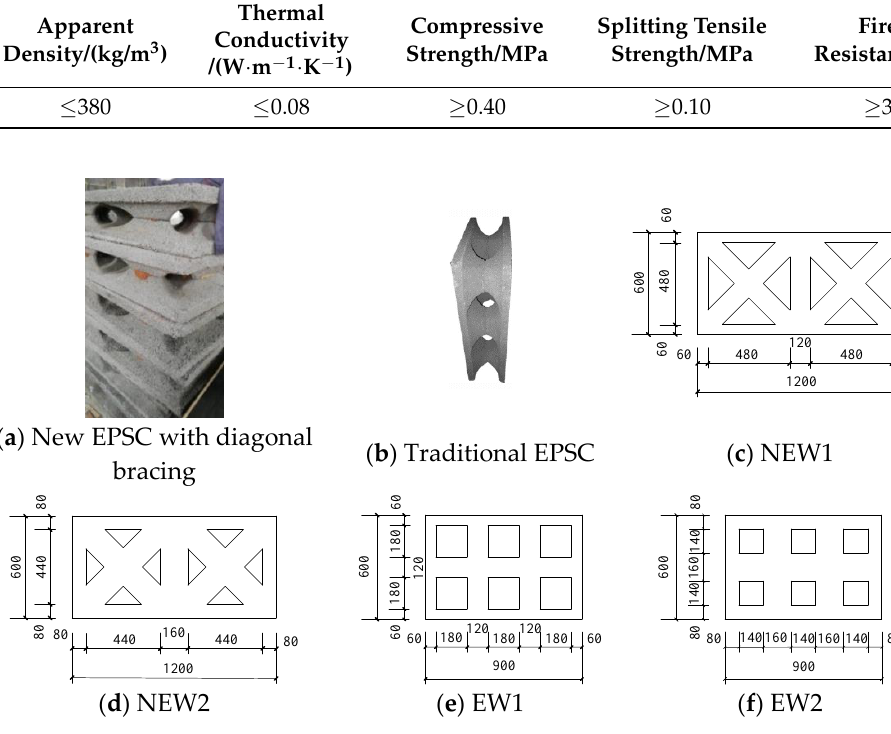
Table 1. Properties of EPSC.